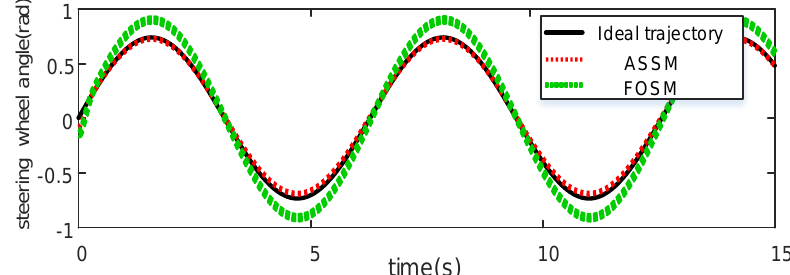
Figure 6. Steering wheel angle.